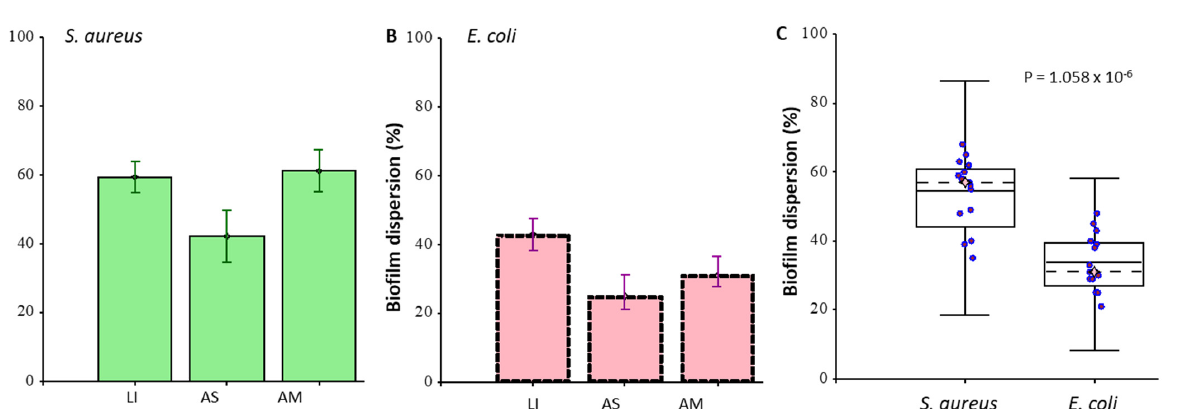
Figure 5. The antibiofilm potential of AgNPs prepared using extracts from L. indica (LI), A. scholaris (AS), and A. multifolium (AM) on S. aureus ( A – C ) and E. coli ( D – F ) cells after exposure 24 and 48 h. The effect was calculated relative to the control without nanoparticles (0%); calculations also considered the intrinsic density of nanoparticles adsorbed on the surface of the plate wells. A boxplot reflects the cumulative effect of all concentrations of one type of particle in an experiment. LB medium, incubation at 37 °C, staining with crystal violet. All measurements were performed in no less than five replicates. For further details, see the chapter Materials and Methods.